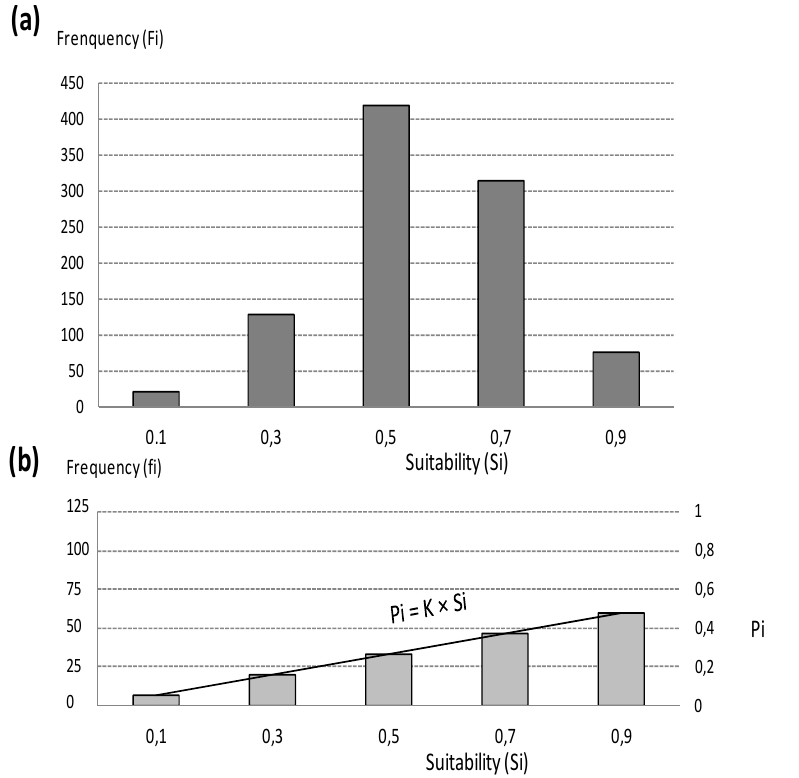
Figure A1. Frequency distribution of all the parcels ( F i ) ( a ); and of the selected parcels ( f i